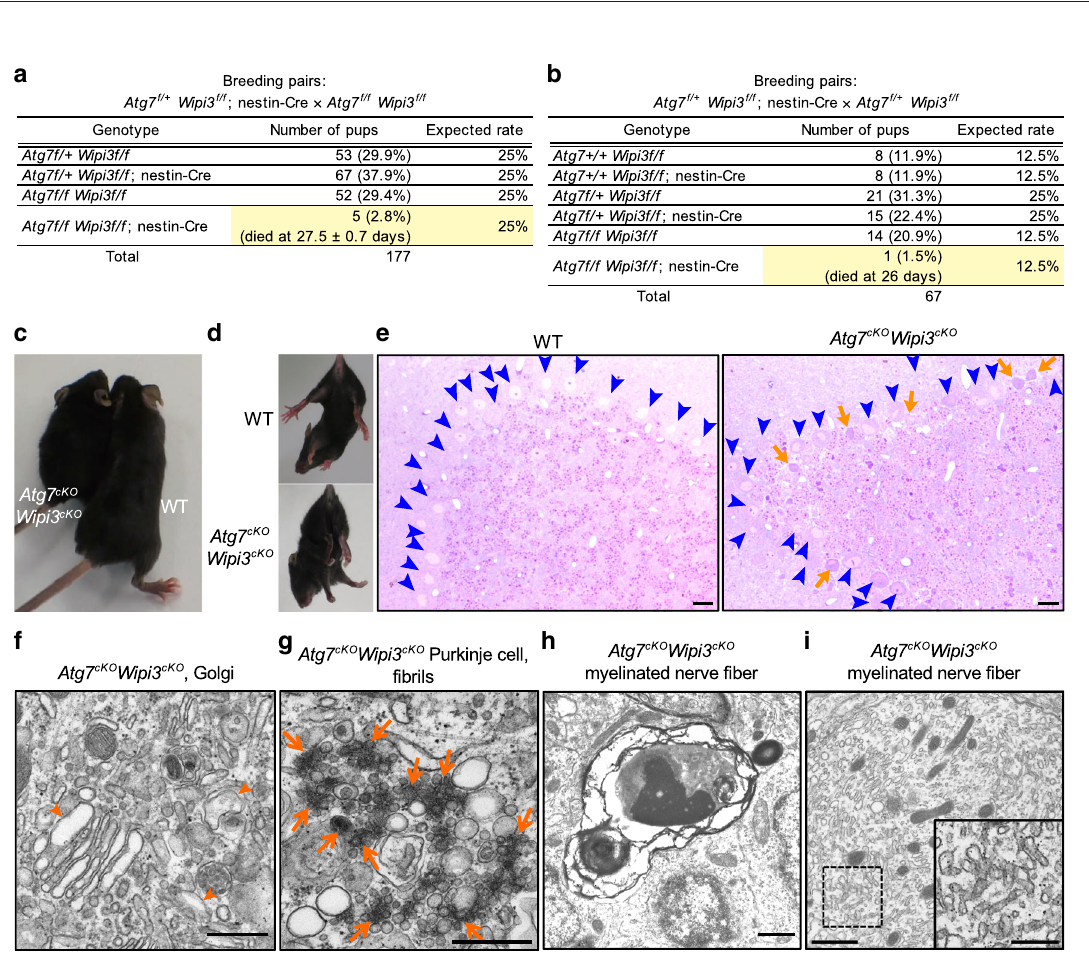
Fig. 10 Atg7 cKO /Wipi3 cKO mice showed a more severe phenotype than single-knockout mice. a , b Tables showing the rate of viable neonates of the different genotypes. “ Expected rate ” indicates the Mendelian ratio. Yellow rows indicate the population of Atg7 cKO /Wipi3 cKO mice. c Gross appearance of the Atg7 cKO /Wipi3 cKO mice at 4 weeks of age. d The limb-clasping re fl ex is observed in Atg7 cKO /Wipi3 cKO mice. e Histological analyses of Atg7 cKO / Wipi3 cKO mice. Semi-thin sections of the cerebellum were stained with toluidine blue. Bars = 20 µ m. Blue arrowheads and orange arrows indicate live and dead Purkinje cells, respectively. f – i EM analysis of Atg7 cKO /Wipi3 cKO mouse brains. f Swollen rod-shaped Golgi membranes were evident in the Purkinje cells from Atg7 cKO /Wipi3 cKO mice (arrowheads). The morphology was similar to that of Wipi3 cKO mouse brains (Fig. 7i). g The accumulation of fi brils was observed in Purkinje cells from Atg7 cKO /Wipi3 cKO mice (arrows), as observed in Wipi3 cKO Purkinje cells (Fig. 7k). h , i Myelinated nerve fi bers of Atg7 cKO / Wipi3 cKO cerebella were fi lled with debris ( h ) and smooth ER ( i ). Bars = 0.5 µ m in ( f , g ) and 1 µ m in ( h , i ). Magni fi ed images of the dashed squares are shown in the insets. Bar = 0.5 µ to the stationary growth phase, and the cells were shifted to YPD medium con- and anti-DMT1 (Proteintech, #20507-1-AP). Enzymes used for recombinant DNA taining AmphoB for 24 h with shaking at 30 °C. techniques were purchased from Takara Bio, TOYOBO, and New England Bio- Labs. All other reagents were obtained from Nacalai Tesque. Electron microscopy . Yeast and mammalian cells were placed between sapphire Yeast strains and media . The yeast strains used in this study are listed in glasses (Niko Optical) or aluminum plates and frozen quickly by soaking in liquid nitrogen. Frozen samples were fractured in liquid nitrogen and fi xed by the quick Table S1. Gene deletions were introduced into the yeast by homologous recom- freeze-substitution method 47 , which achieves good preservation of cellular bination. Transformation into yeast was performed using the standard lithium acetate method. For AmphoB treatment, yeast cells were cultured in YPD medium architecture.